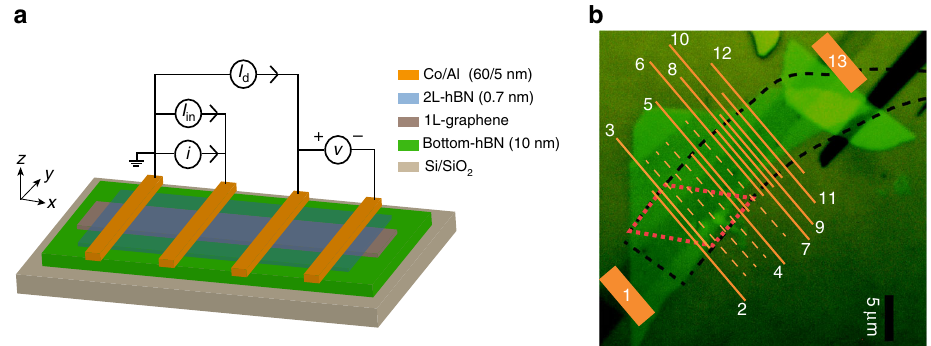
Fig. 1 Device layout and measurement scheme. a A layer-by-layer schematic of the vdW heterostructure of the 2L-hBN/graphene/thick-hBN stack with FM cobalt electrodes. A measurement scheme is shown for the non-local spin transport measurements with a DC current bias I in and AC current i , applied across the injector contacts and a non-local differential (AC) spin signal v is measured using a lock-in detection technique. A DC current bias I d can also be applied in order to bias the detector contact. b An optical microscopic picture of the vdW heterostructure. Scale bar , 5 μ m. The black-dashed line outlines the hBN tunnel barrier fl ake. The red-dashed line outlines the monolayer region of the hBN tunnel barrier fl ake (see Supplementary Note 1 for the optical microscopic picture of the tunnel barrier). A schematic of the deposited cobalt electrodes is shown as orange bars and the Co/hBN/graphene contacts are denoted by numbers 1, 2, .., and 13. The orange-dashed lines represent the unused contacts. Cobalt electrodes from 2 to 5 are either fully or partially deposited on top of the monolayer region of the tunnel-barrier fl ake, while the electrodes from 6 to 12 are exclusively deposited on the bilayer region. The width of the cobalt electrodes (2 – 12) is varied between 0.15 and 0.4 μ